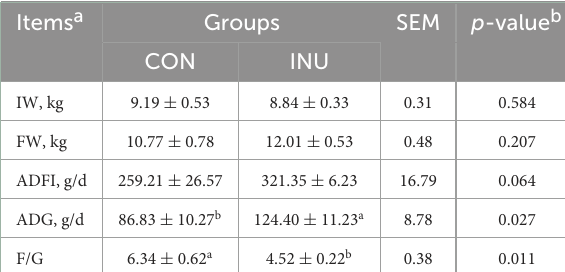
TABLE 3 The growth performance of weaned kids fed low-carbon high-inulin (INU) and maize-grain based control (CON) diets,